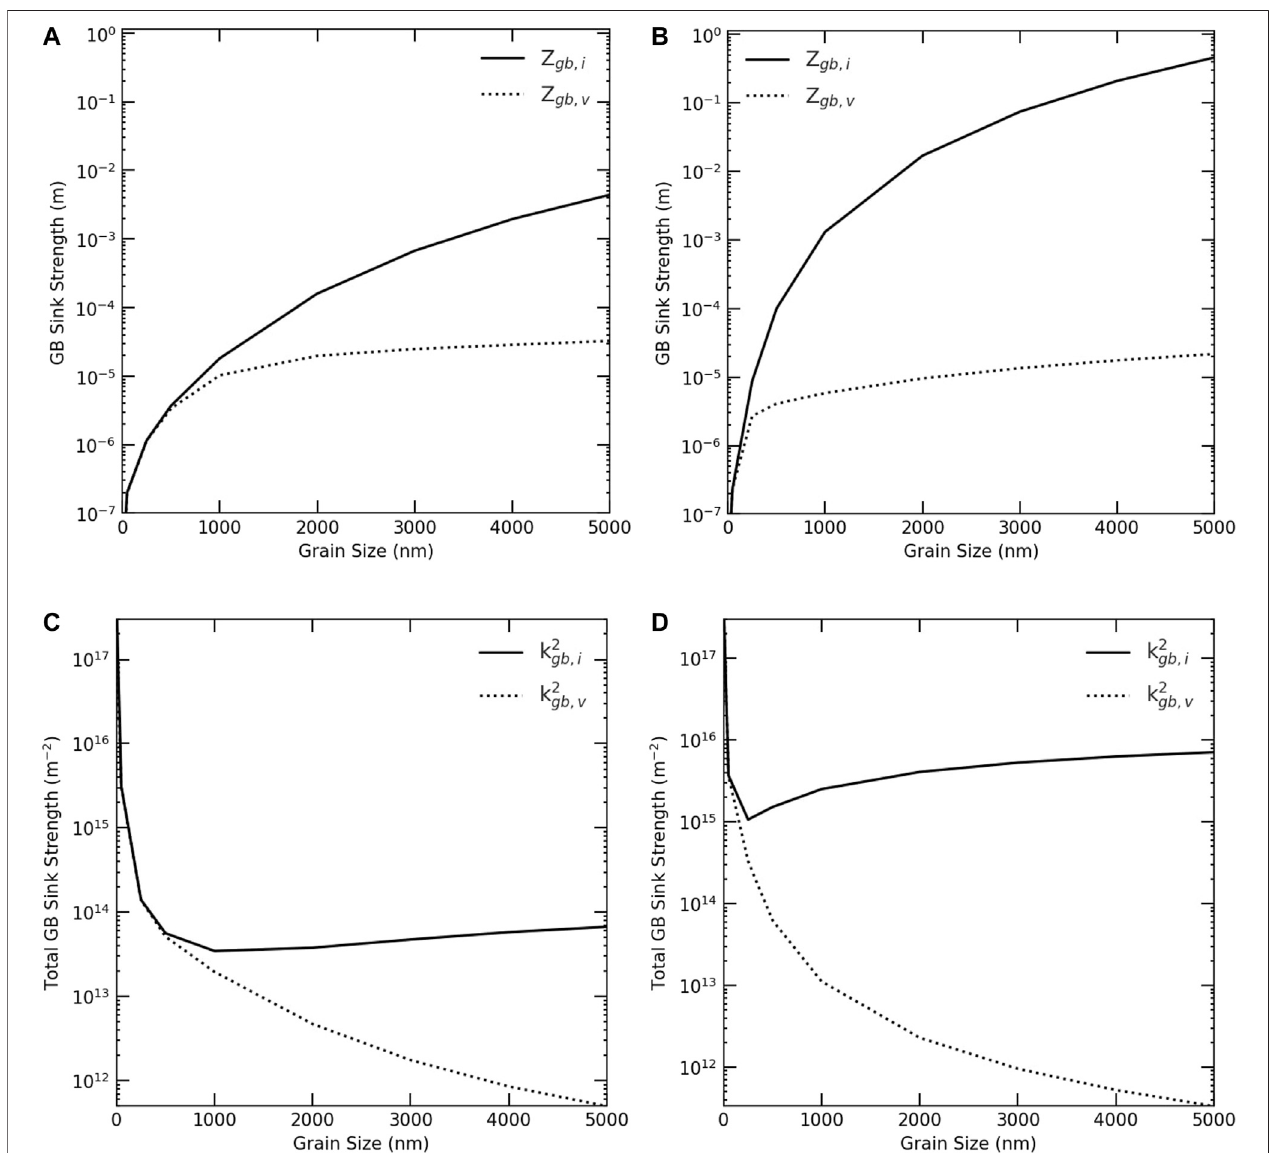
FIGURE 9 | Change of grain boundary sink strengths with grain size for 5% production bias. Upper row : Individual grain boundary sink strengths, Z gb , i and Z gb , v , for (A) lowdoserate(1e-6 dpa/s),and (B) highdoserate(1e-3 dpa / s ). Lowerrow :Totalgrainboundarysinkstrengths, k 2 gb , i and k 2 gb , v ,for (C) lowdoserate(1e-6 dpa/s), and (D) high dose rate (1e-3 dpa/s). Because of the size- and dose rate-dependent instability, the individual and total boundary sink strengths for interstitials are higher than vacancies above the critical size. This indicates that the boundary changes from neutral to biased at the critical size.